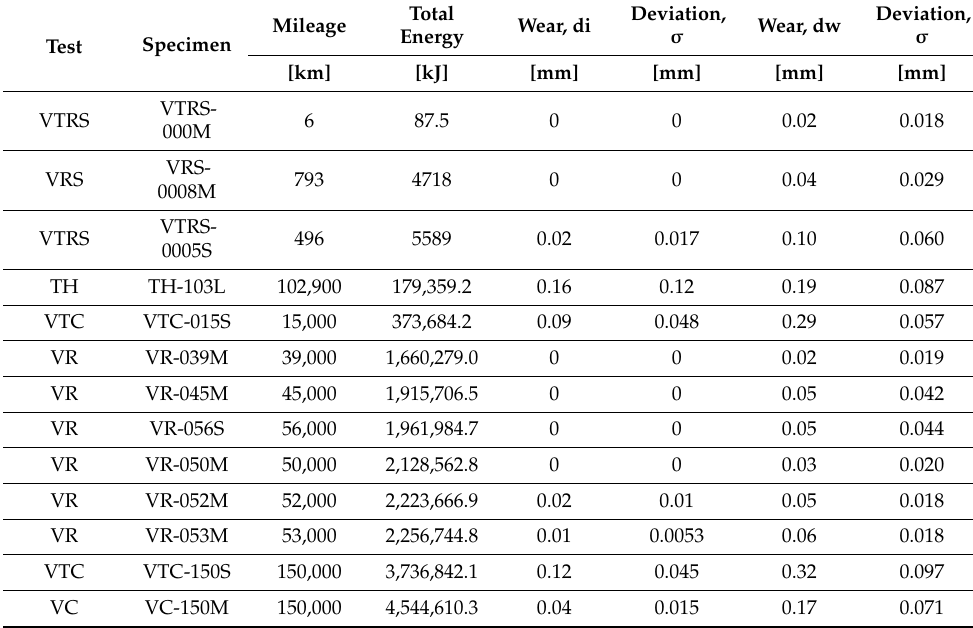
Table 6. Wear values of facings after different automotive